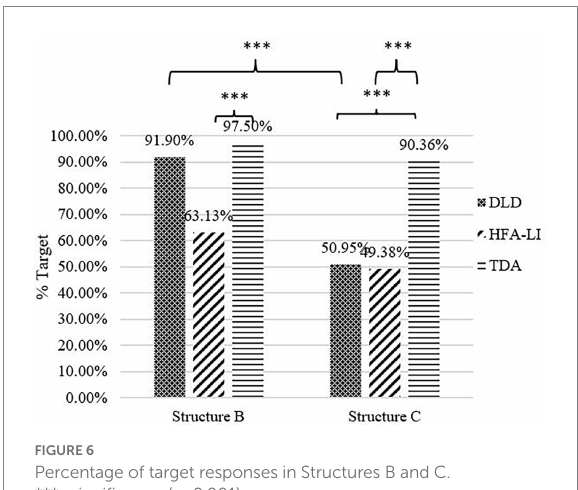
FIGURE 6 Percentage of target responses in Structures B and C. *** = significance ( p < 0.001).